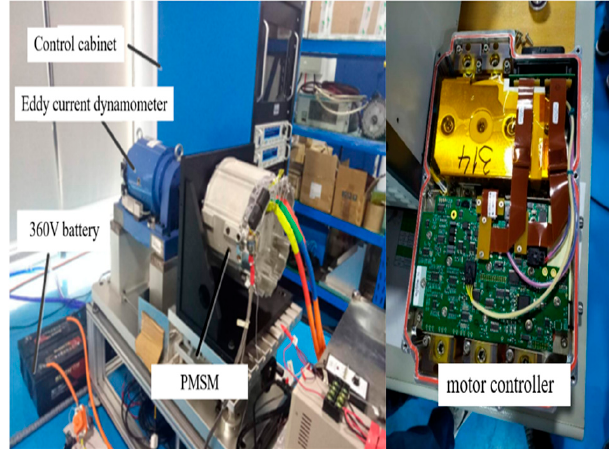
Figure 7. Experimental platform and motor controller.